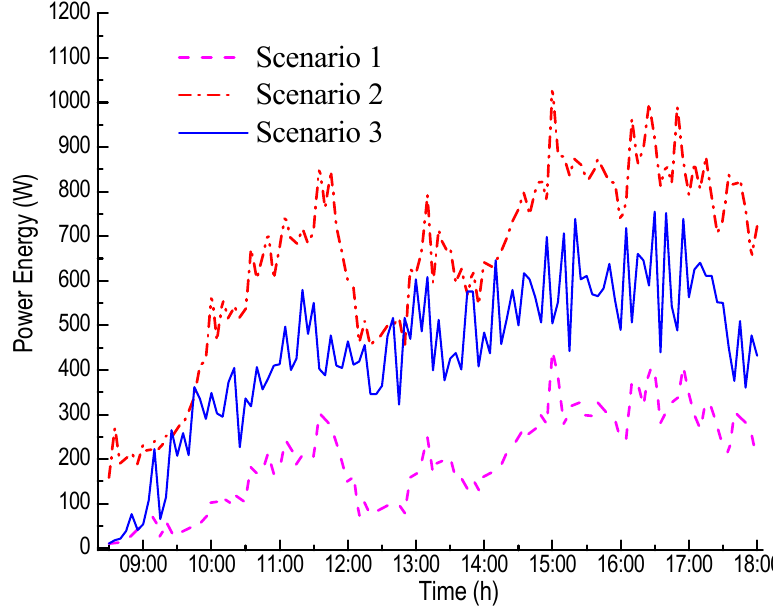
Figure 15. Total power energy of fans under three scenarios.